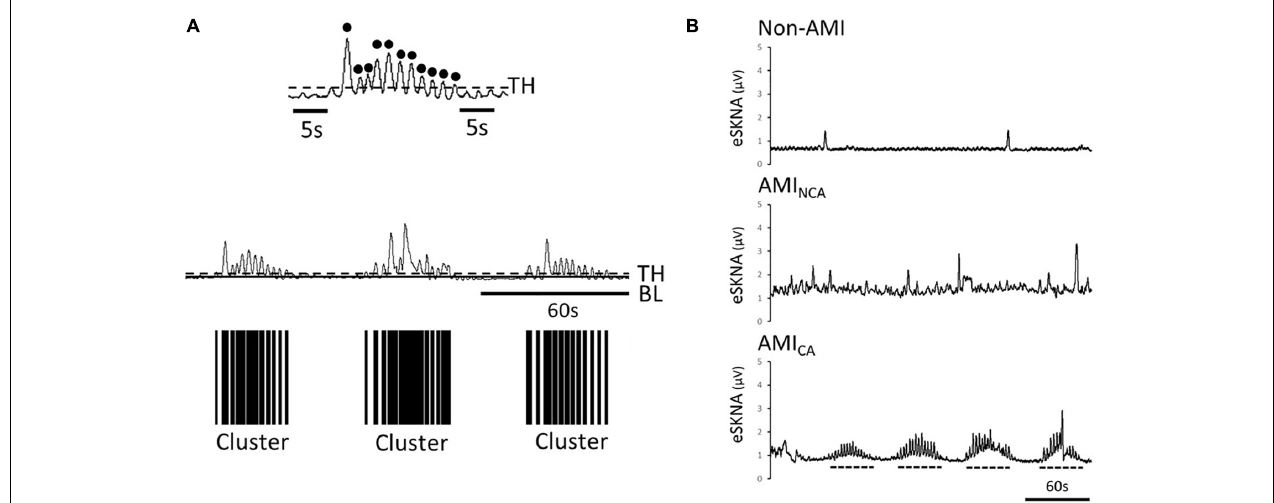
FIGURE 2 | (A) Black dots are the defined bursts, which are the peaks above the threshold. Definition of a cluster, which is defined to contain at least five bursts within 10–60 s and without any bursts before/after the cluster in 5 s. The black bars are the clusters found in the eSKNA. The distribution of the black bars shows the clustering phenomenon. TH, threshold; BL, baseline. (B) Examples of eSKNA in non-AMI, AMI NCA , and AMI CA showing the morphological difference. The non-AMI group is relatively stable compared to the AMI group that shows sporadic bursts. The AMI NCA group has higher variance and irregular bursts. The AMI CA group can observe the obvious clustering phenomenon. Dotted lines indicate the